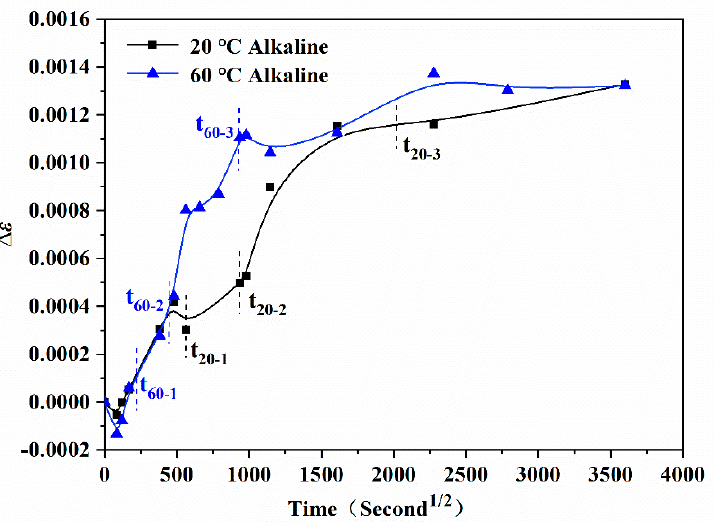
Figure 8. Variation of internal strain of epoxy resin specimens immersed in the alkali solution at 20 °C and 60 °C. Table 3. Strain of epoxy resin samples immersed in the alkali solution at different temperatures.